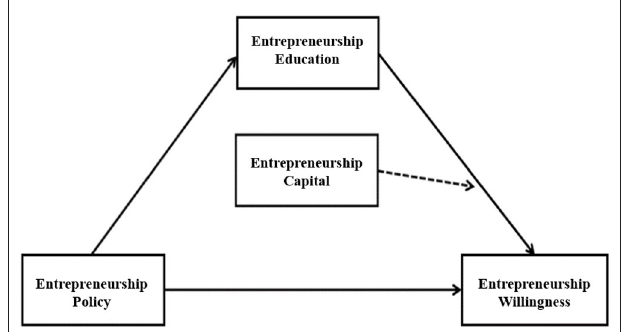
FIGURE 1 | Moderated mediation model of entrepreneurship education, policy, and